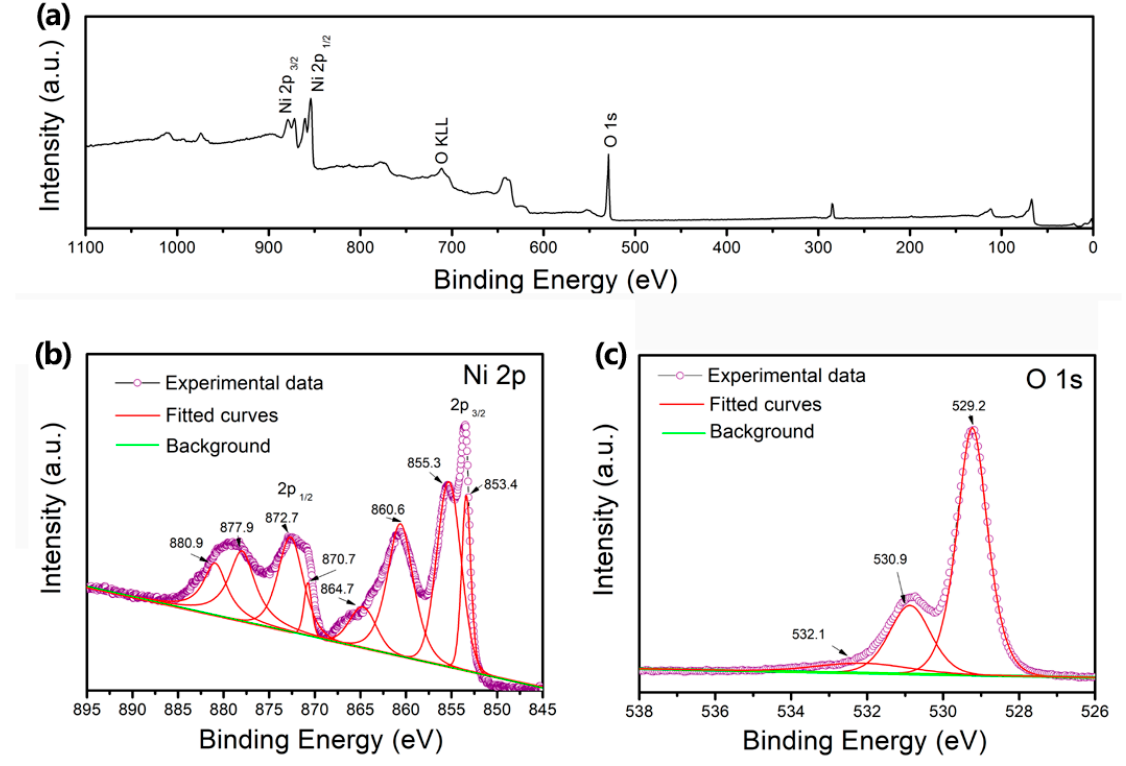
Figure 4. X-ray photoelectron spectroscopy (XPS) spectrum of as-prepared NiO sub-microsphere: ( a ) survey spectrum; ( b ) Ni 2p spectrum; and ( c ) O 1s spectrum.